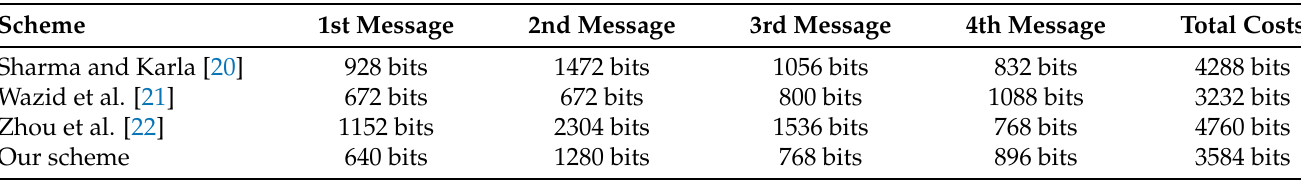
Table 6. A communication cost